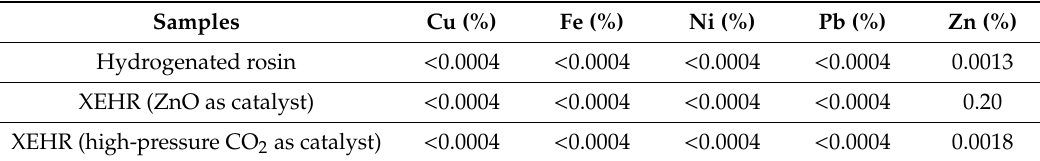
Table 2. Cu, Fe, Pb, Zn, and Ni concentrations in the hydrogenated rosin (row 1), XEHR generated by ZnO catalysis (row 2), and XEHR generated by high-pressure CO 2 catalysis (row 3) as determined by